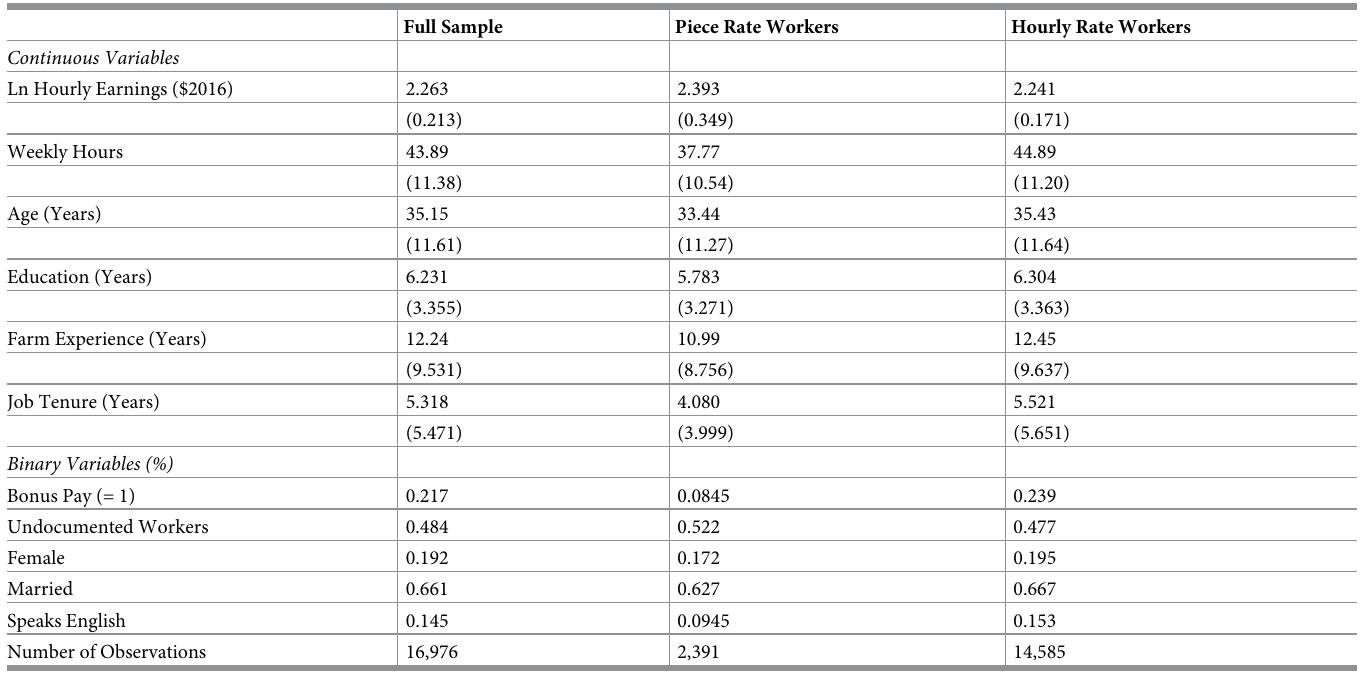
Table 4. Summary statistics (national agricultural workers